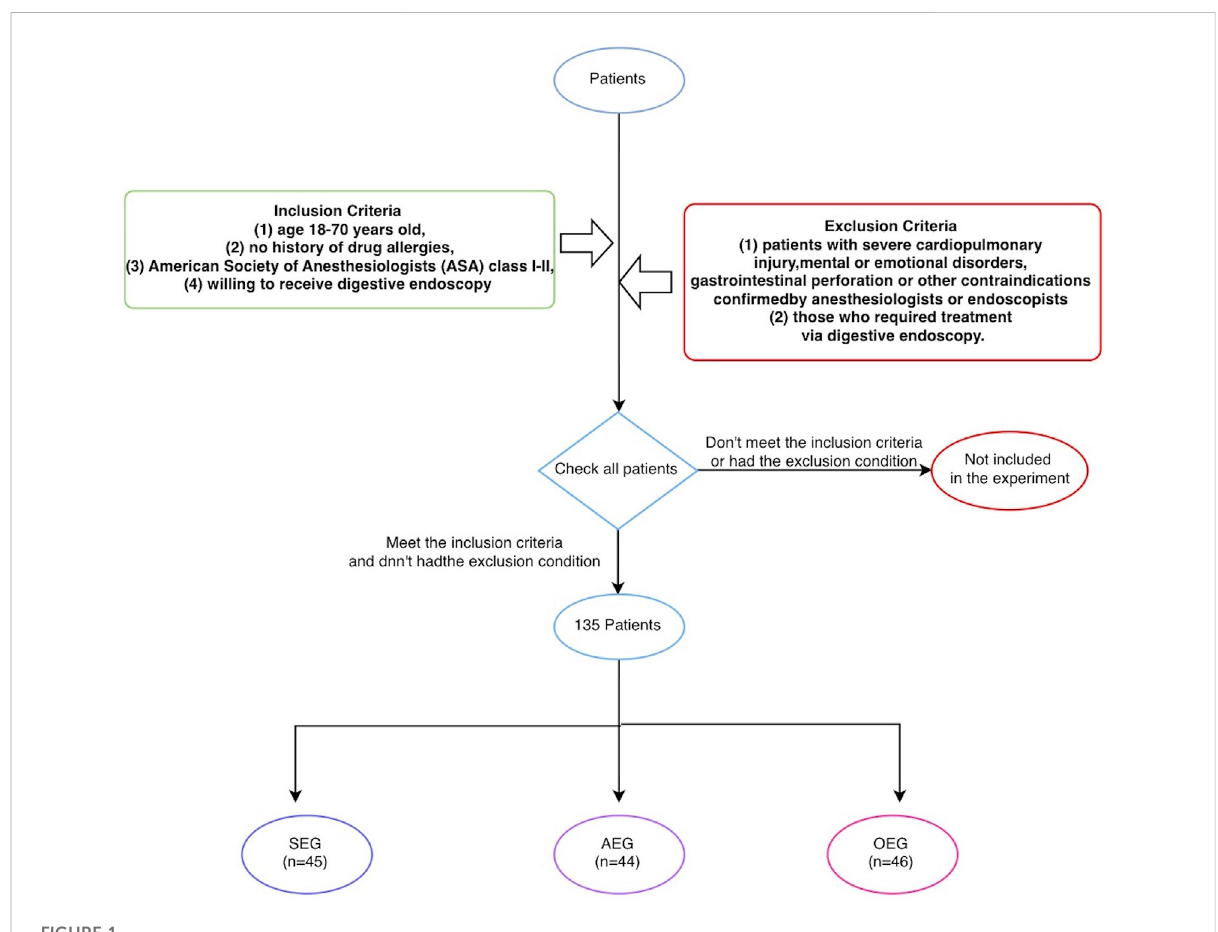
FIGURE 1 The process of grouping